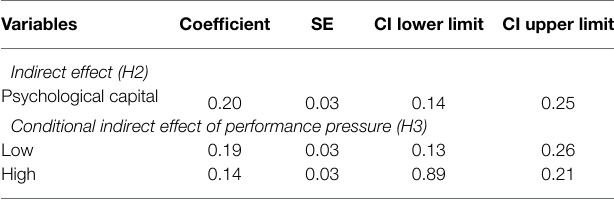
TABLE 4 | Results of bootstrapped indirect effect